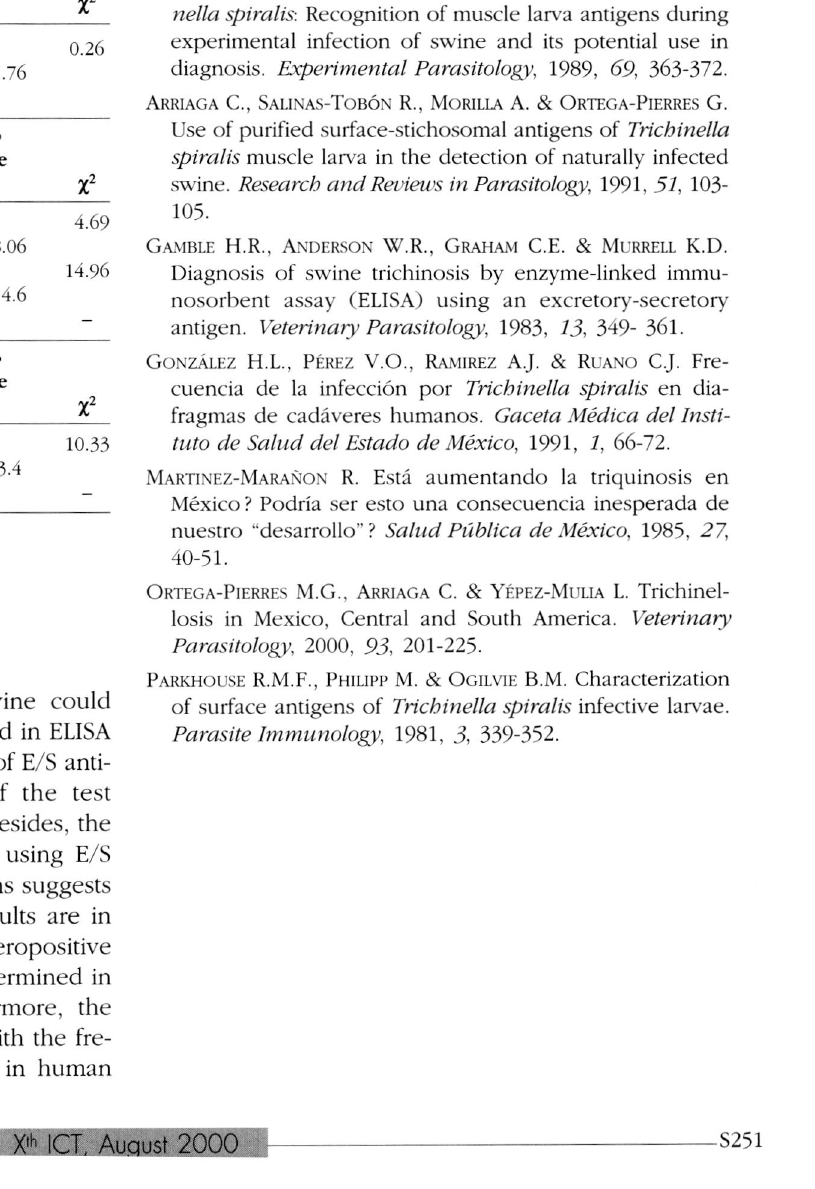
Table II. - Epidemiological Analysis of Western blot